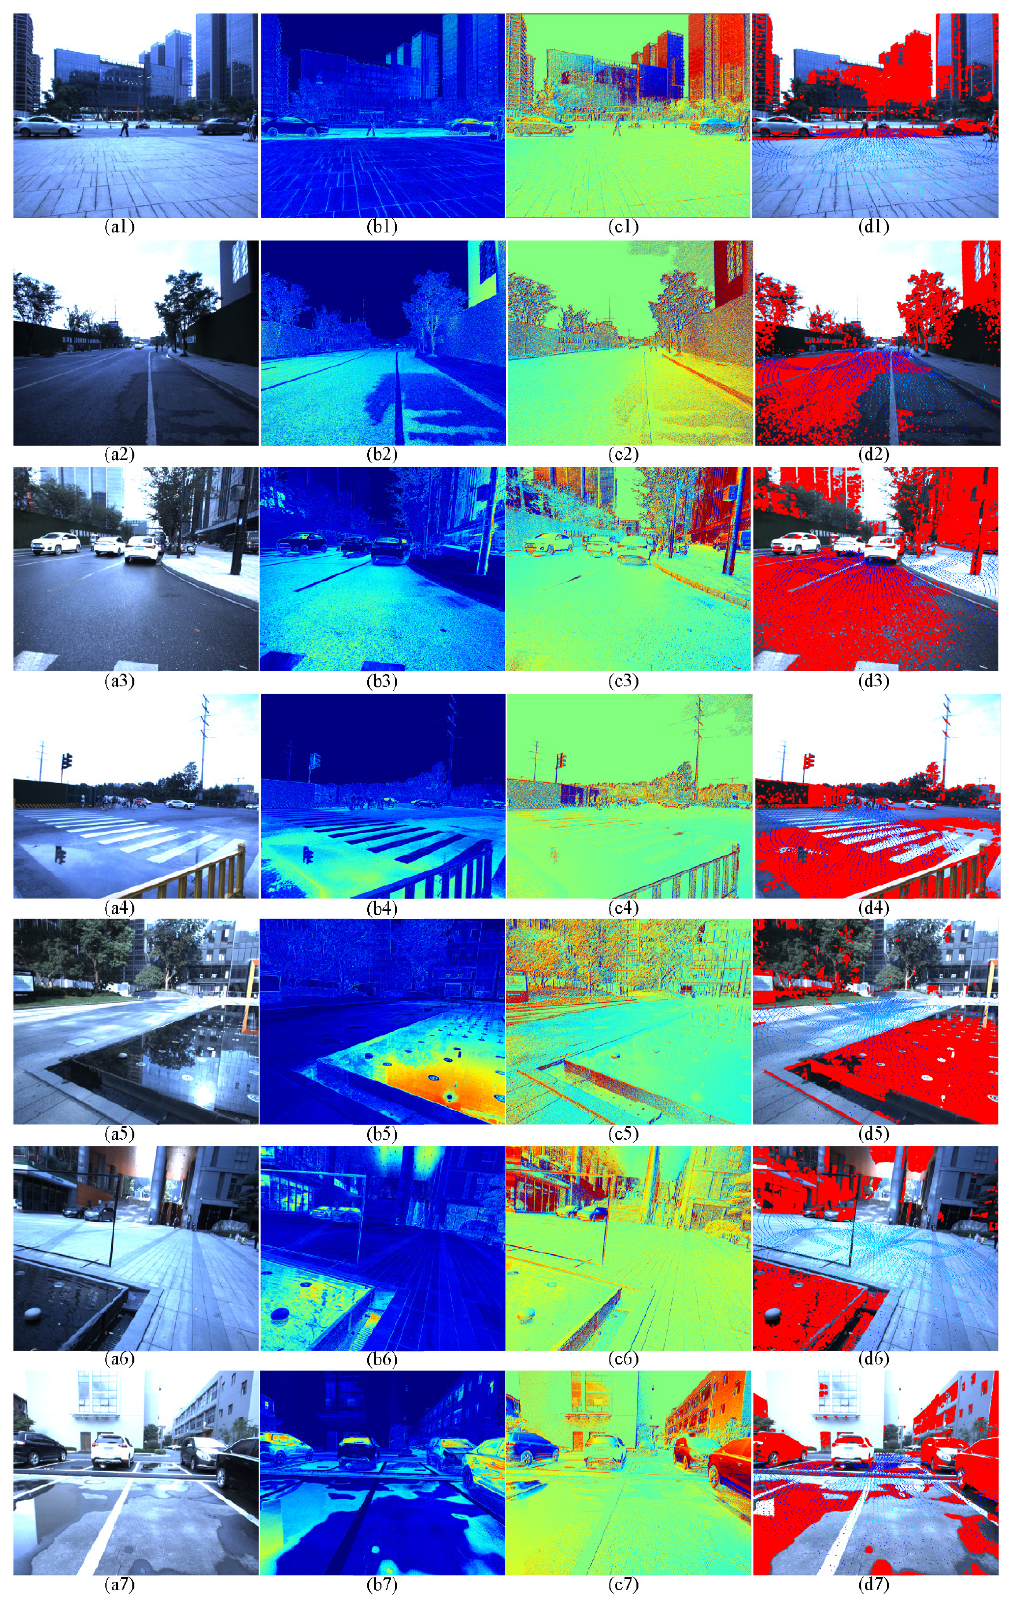
Figure 13. The slippery road surface and puddles detection results by the polarization information and the LiDAR point cloud: ( a1 – a7 ) the color image with zero-degree polarization; ( b1 – b7 ) the